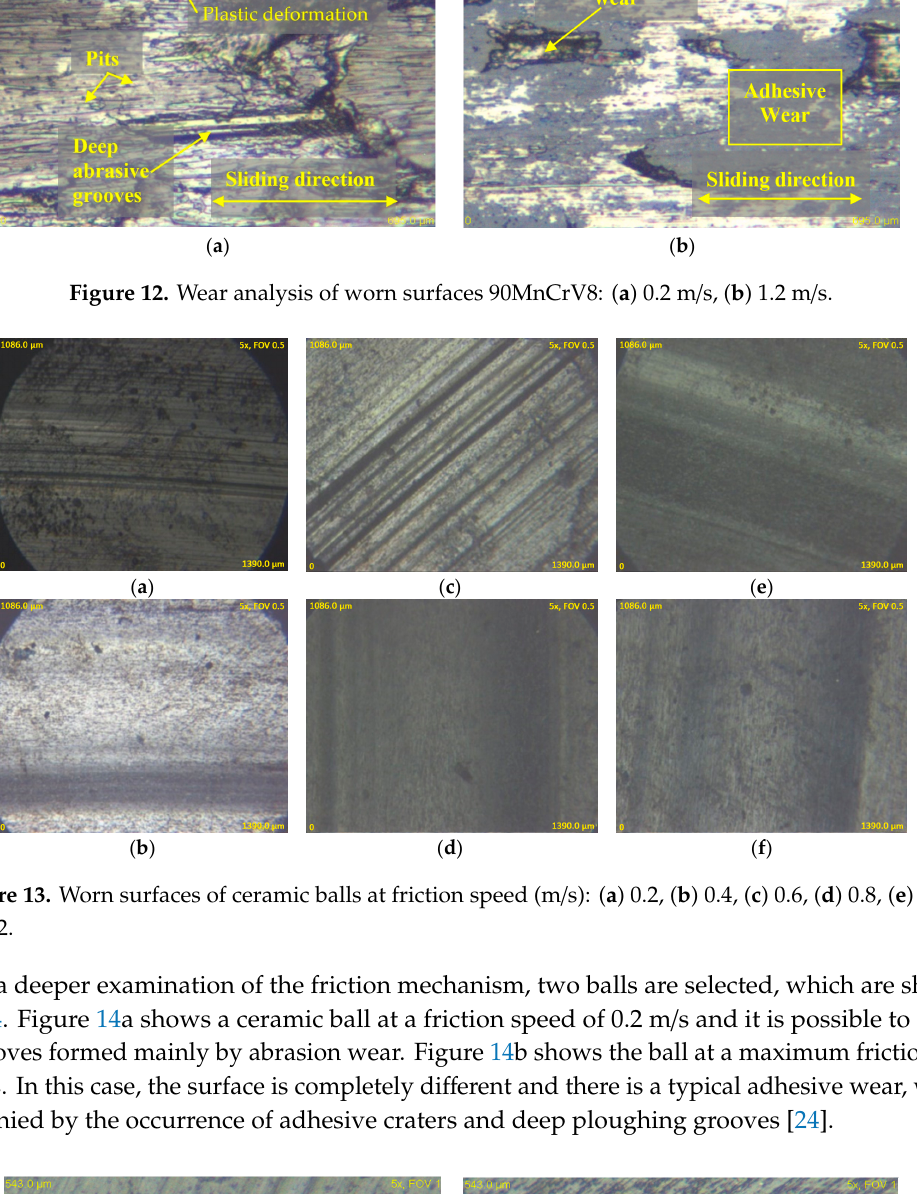
Figure 13. Worn surfaces of ceramic balls at friction speed (m/s): ( a ) 0.2, ( b ) 0.4, ( c ) 0.6, ( d ) 0.8, ( e ) 1.0,